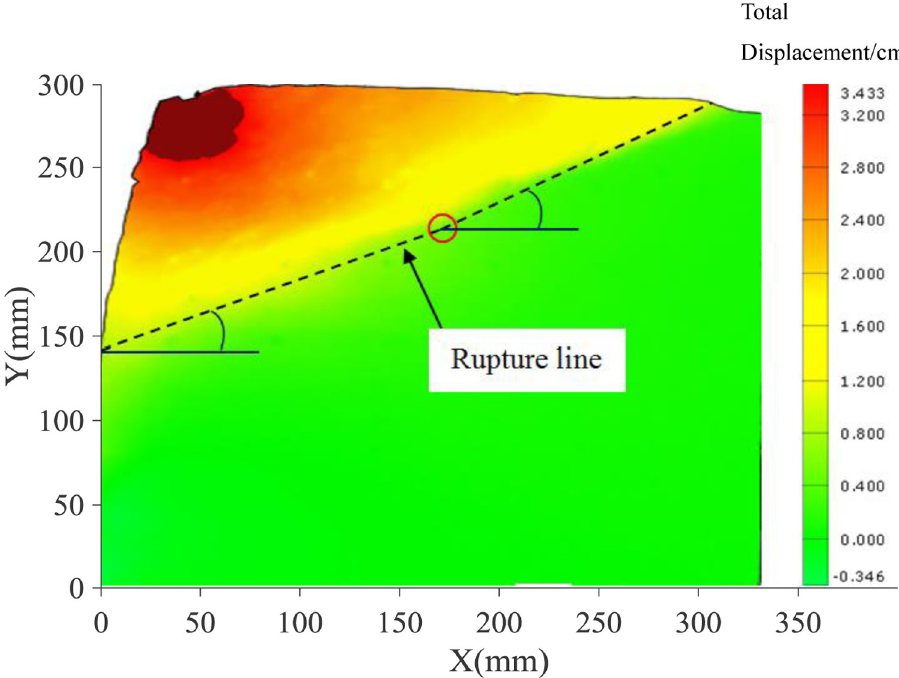
Fig 7. Nephogram of displacement in final state (300mm).